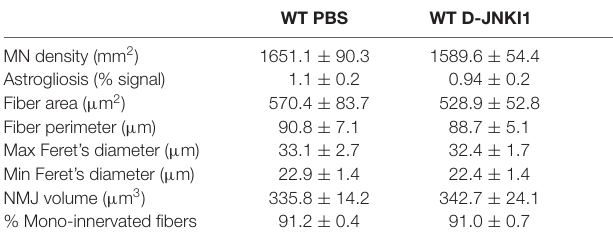
TABLE 1 | Parameters analyzed in the comparison between PBS-treated and D-JNKI1-treated WT mice at P12. WT PBS WT D-JNKI1